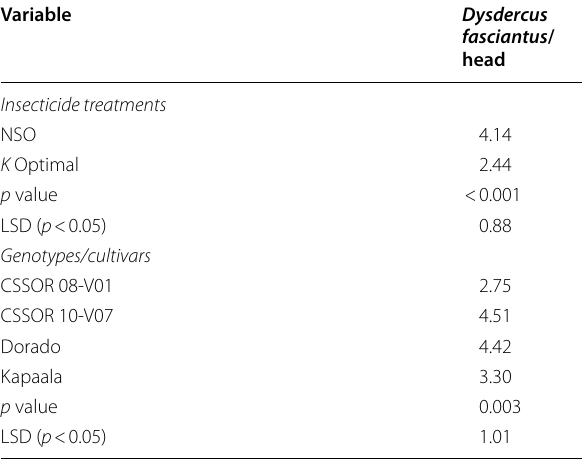
LSD least significant difference at 5% probability threshold = Table 2 Effect of Insecticide treatments and sorghum Genotypes/Cultivars on Dysdercus fasciantus infestations/head